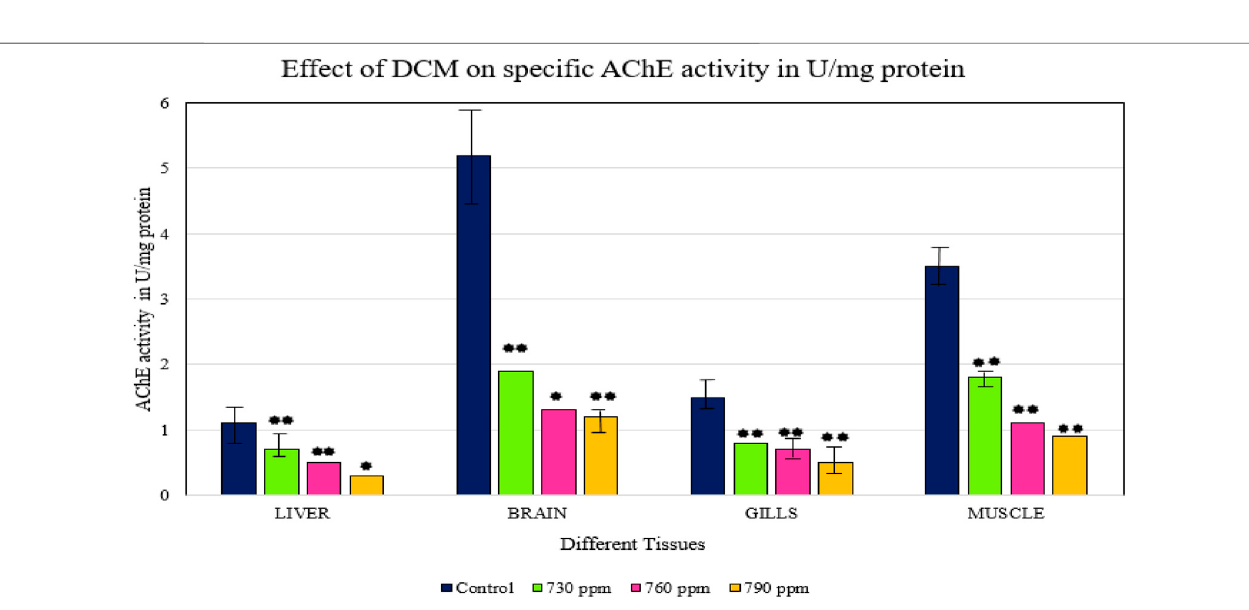
Frontiers in Environmental Science |